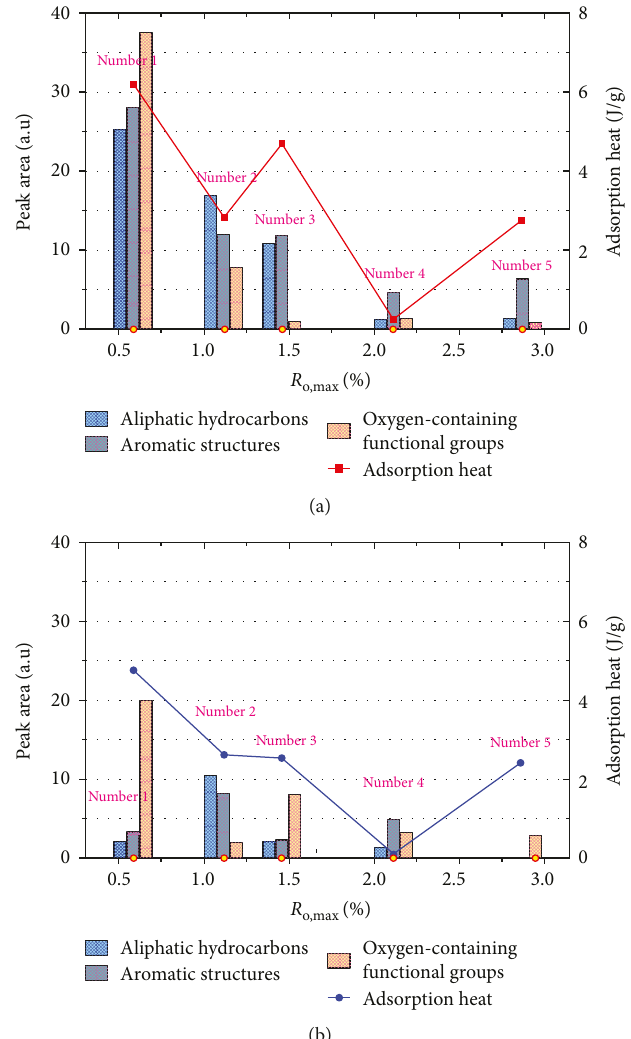
Figure 12: Correlation between the adsorption heat and the surface functional groups of vitrinite (a) and inertinite (b)